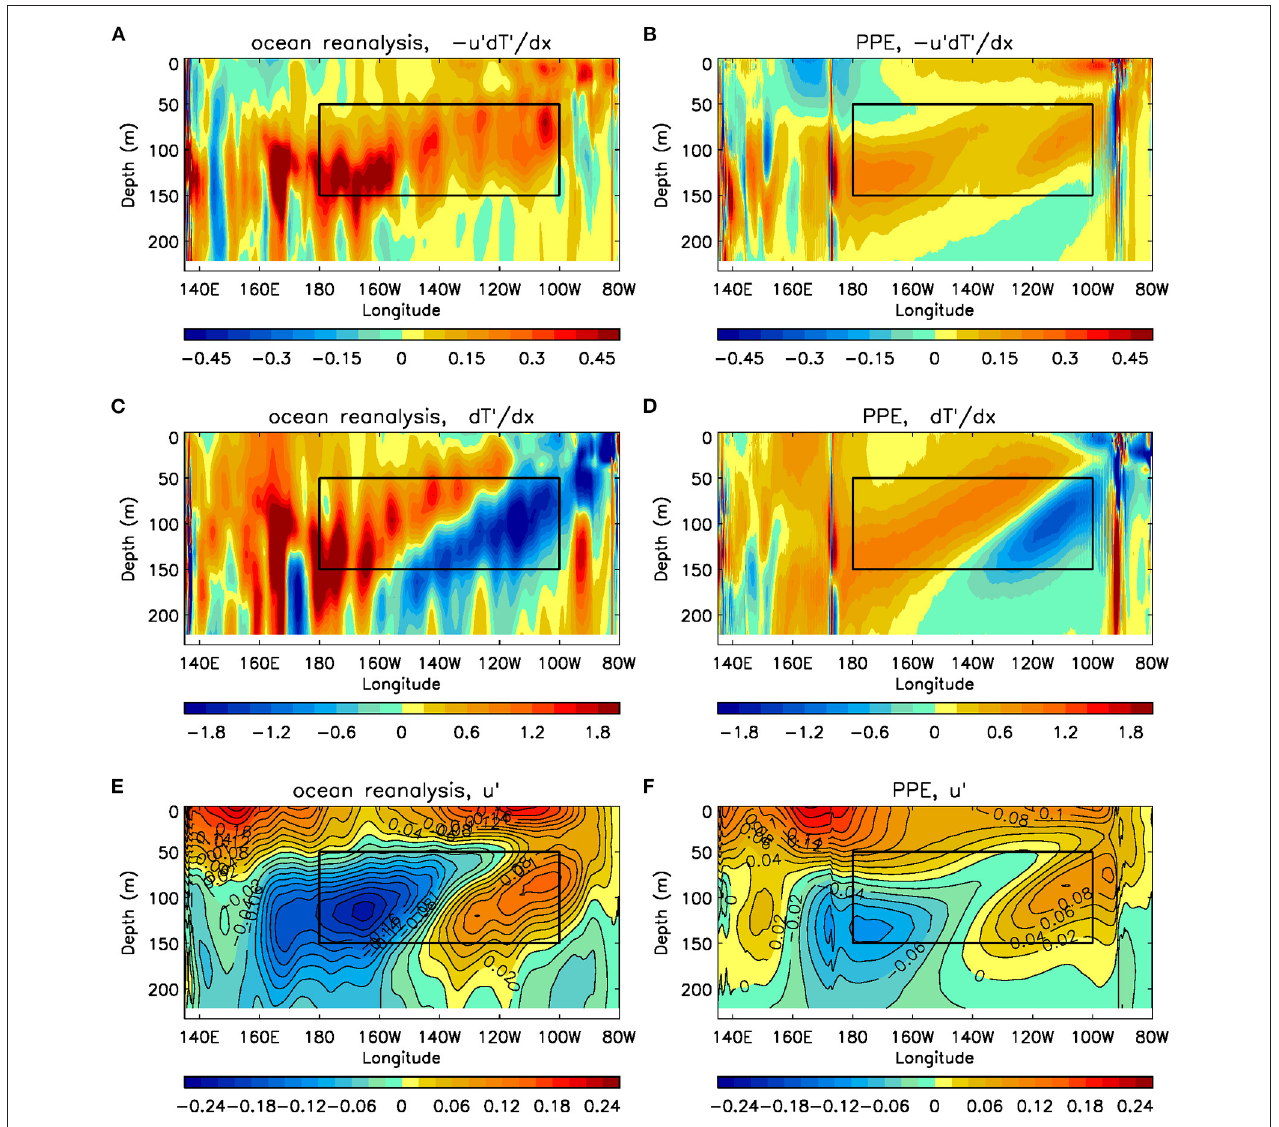
FIGURE 5 | Decomposition of zonal component of non-linear advection. Zonal component of non-linear advection (K month − 1 ) for combined ocean reanalysis (A) and combined PPE (B) , zonal gradient of temperature anomaly (K m − 1 ) for combined ocean reanalysis (C) and combined PPE (D) , and zonal current anomaly (ms − 1 ) for combined ocean reanalysis (E) and combined PPE (F) . Sections are for 1 ◦ N-1 ◦ S, for the growth period of ENSO, El Niño plus La Niña for (A,B) and El Niño minus La Niña for (C–F) . The combined ocean analysis data have been